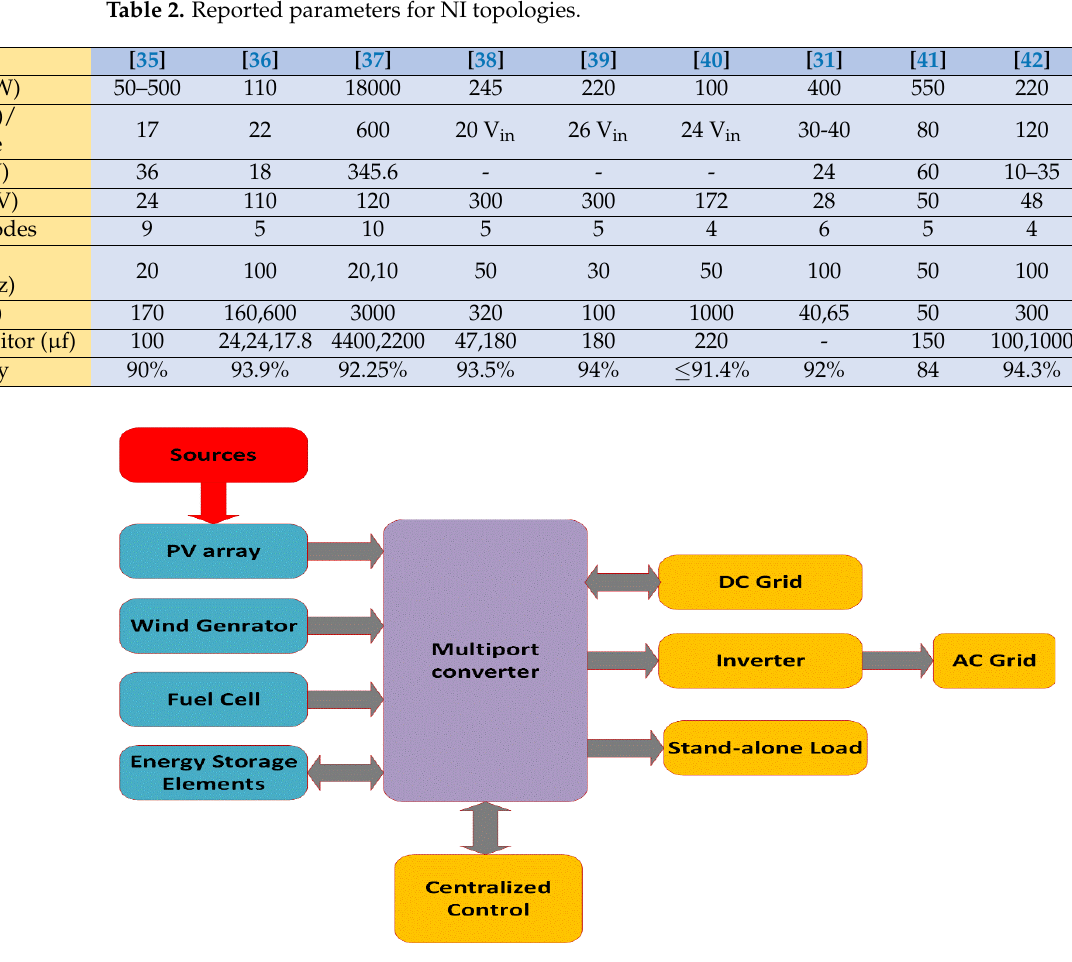
Table 2. Reported parameters for NI topologies.